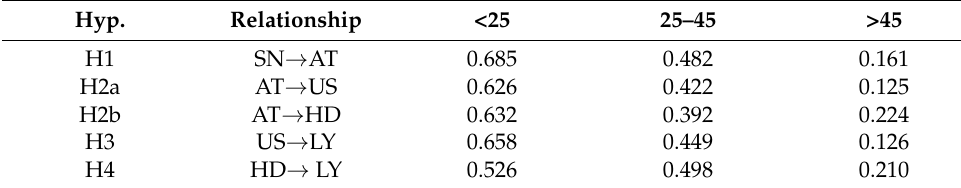
Table 10. Multigroup Ages